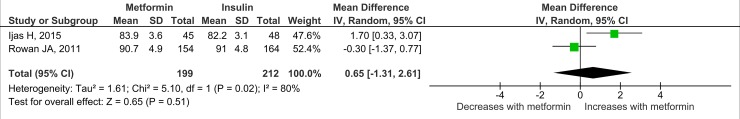
Infant height.Expressed as mean differences (random effects model) and 95% CI. IV, mean difference.